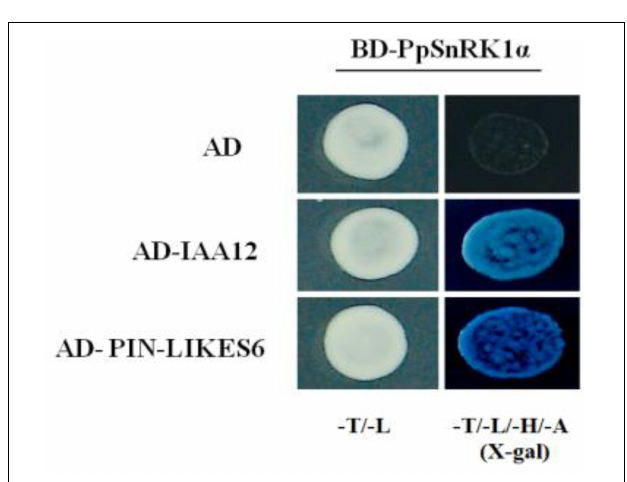
FIGURE 8 | Results of the yeast two-hybrid assay showing the interactions between PpSnRK1 α and IAA12/PIN6. Results are from one representative experiment out of three independent